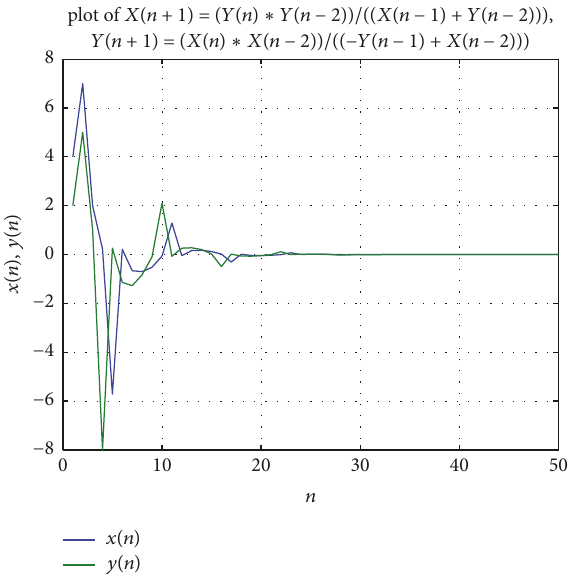
Figure 3: This figure shows the solution of (23).